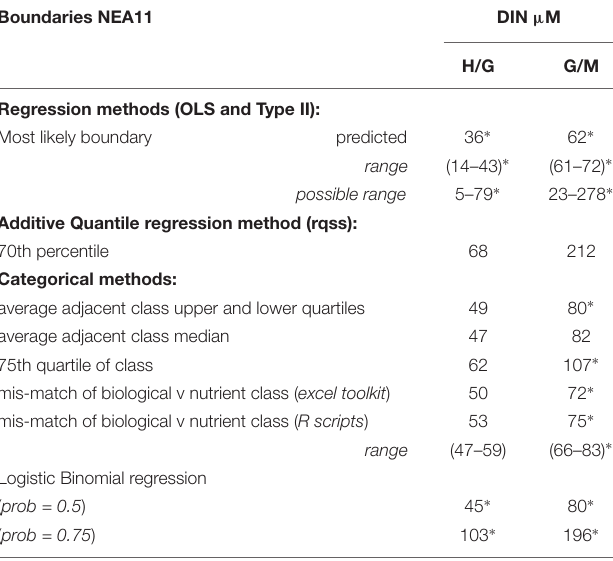
TABLE 6 | Predicted boundary values for DIN ( µ M) in common type NEA11 ( n = 160), derived from the most adequate approaches for this dataset. Boundaries NEA11 DIN µ